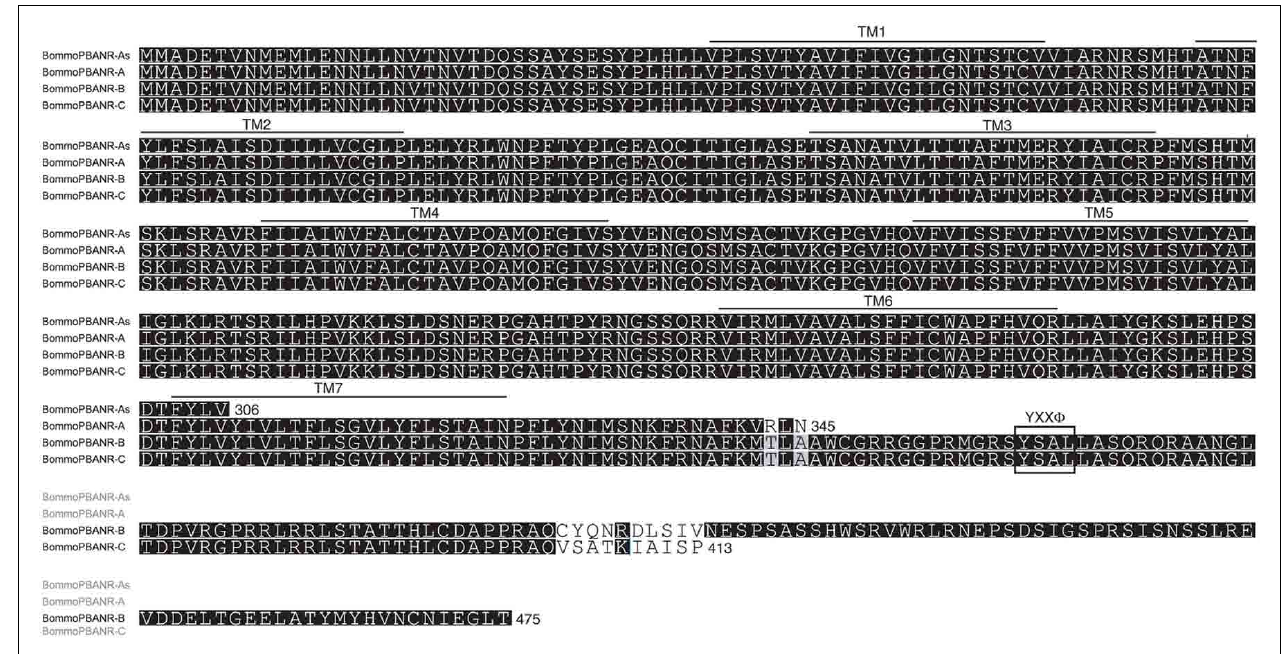
MAFFT v6.814b (Katoh et al., 2002) with certain gaps removed. Species abbreviations are per National Center for Biotechnology Information/Swiss Prot: Bommo, B. mori